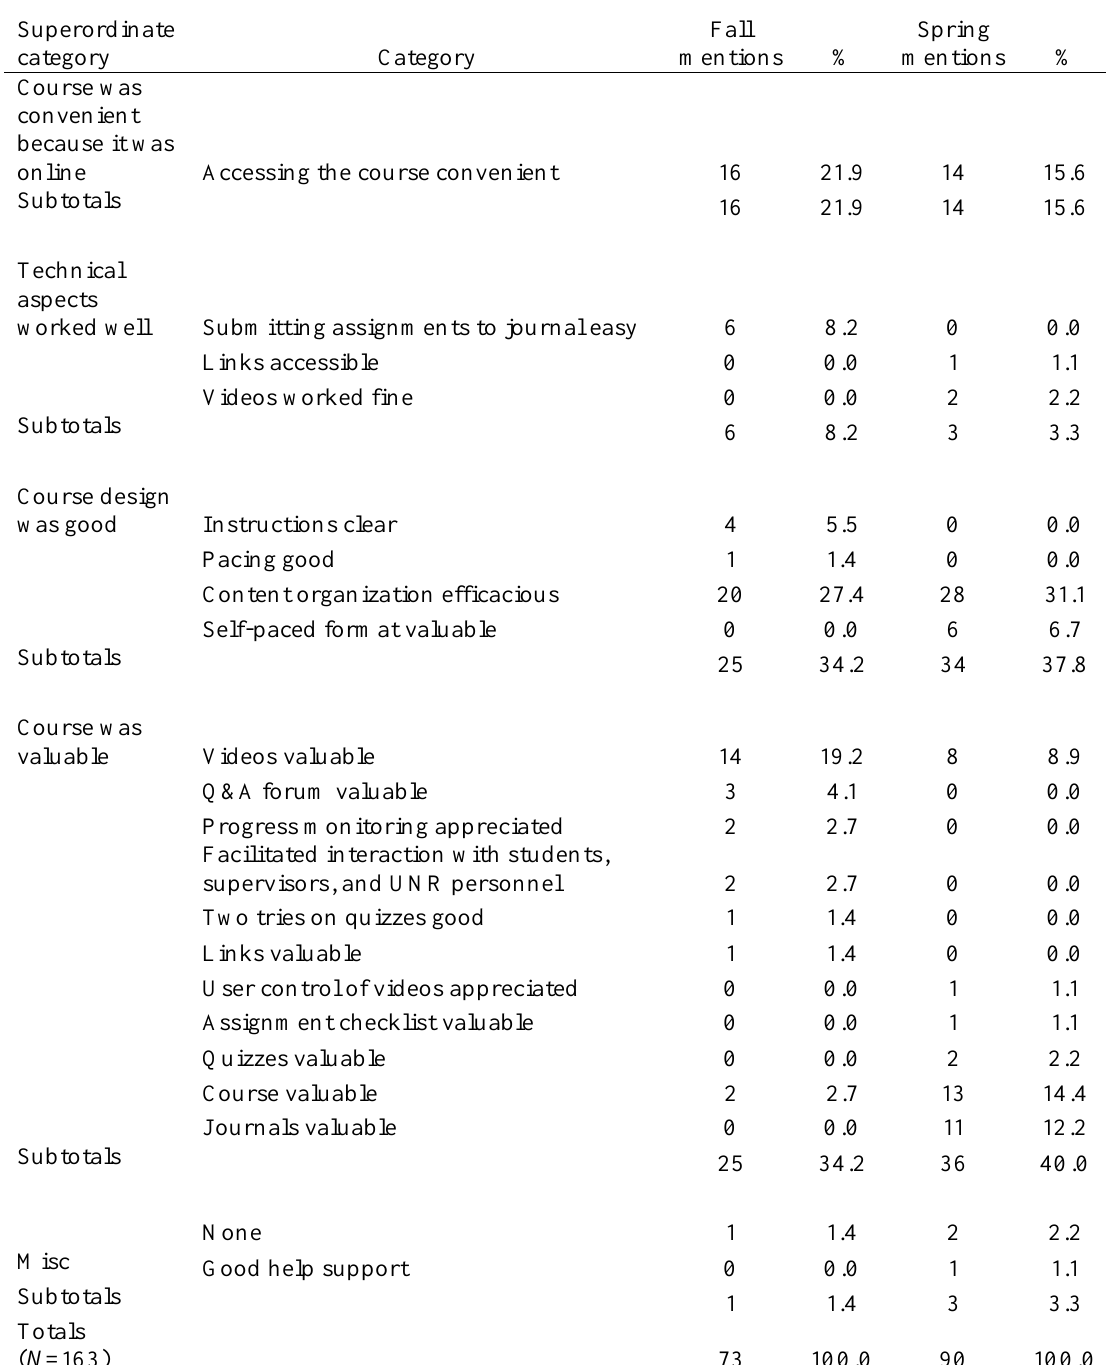
Table 2 Number of Mentions and Percentages of Categories for Item 2: Positive Comments about WebCampus